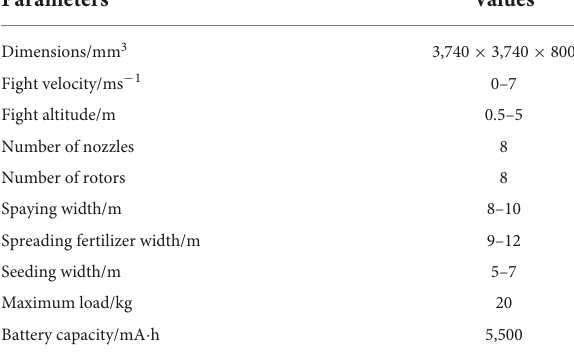
TABLE 1 Basic parameters of the multifunctional UAV.